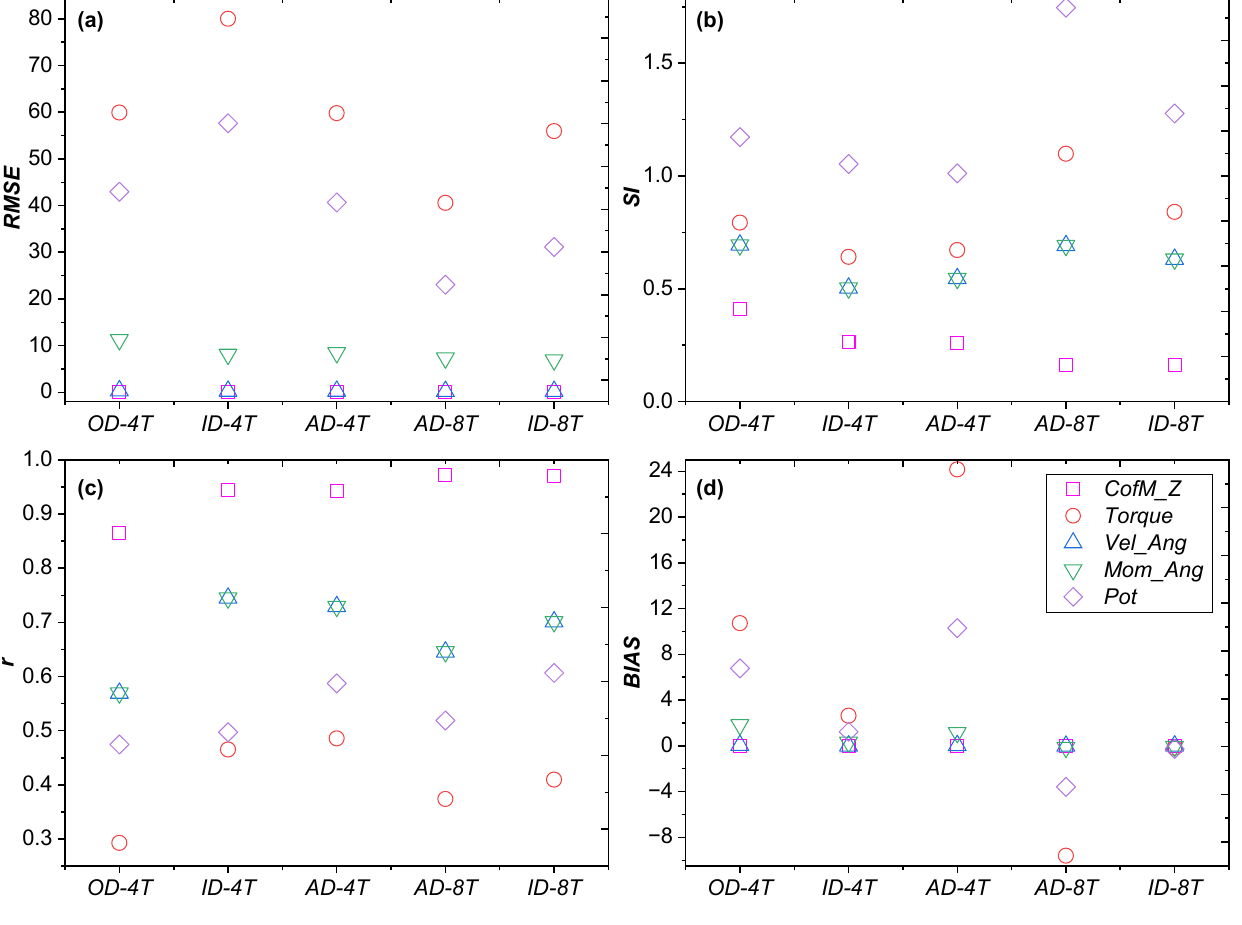
Figure 7. Statistical analysis for the center of mass ( CofM_Z ), angular momentum ( Mom_Ang ), angular velocity ( Vel_Ang ), torque, and output power ( Pot ) for the cases presented in Table 5. ( a ) Root Mean Square Error (RMSE); ( b ) Scatter Index ( SI ); ( c ) Pearson correlation coefficient (r); ( d ) underestimation or overestimation tendency (BIAS).